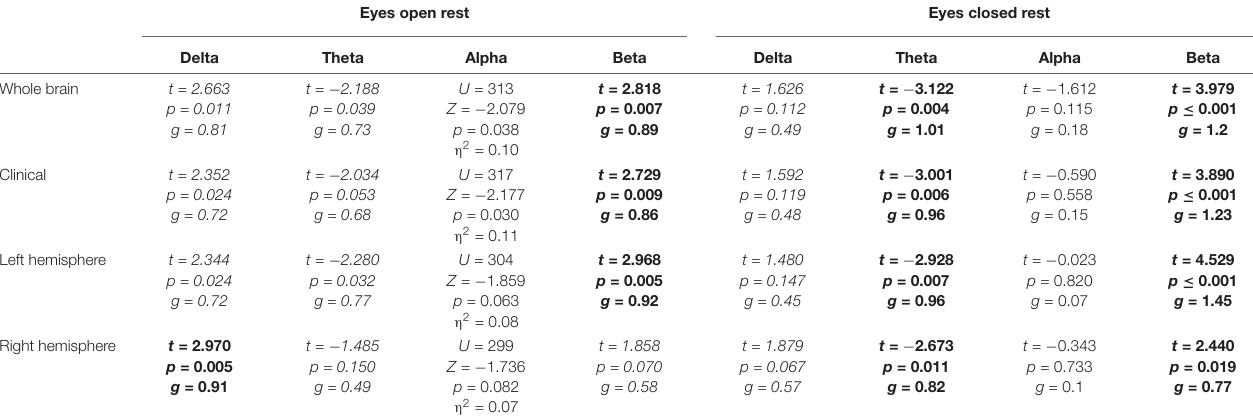
FIGURE 4 | Boxplots display the absolute power (in microvolts) of each frequency band by group and montage for (A) the eyes open; and (B) the eyes closed condition. Black bars indicate statistically significant comparisons with large effects (corresponding to bolded cells in Table 5 ). Gray bars indicate comparisons that were not significant after corrections for multiple comparisons but that had medium to large effect sizes (corresponding to italicized cells in Table 5 ). (In a boxplot, data are split into quartiles and the figure attributes are as follows: the top of the box represents the third quartile; the bottom of the box represents the first quartile; the length of the box from the top to the bottom represents the interquartile range; the horizontal line within the box is the median of the dataset; the upper whisker is the line from the top of the box to the maximum value, or in the presence of an outlier, 1.5 times the interquartile range above the third quartile; the lower whisker is the line from the bottom of the box to the minimum value, or in the presence of an outlier, to 1.5 times the interquartile range below the first quartile; circles and stars represent outliers, defined as any point beyond 1.5 times the interquartile range either above the third quartile or below the first quartile). TABLE 5 | Test statistic, p -value, and effect size for between group comparisons during eyes open and eyes closed rest. Eyes open rest Eyes closed